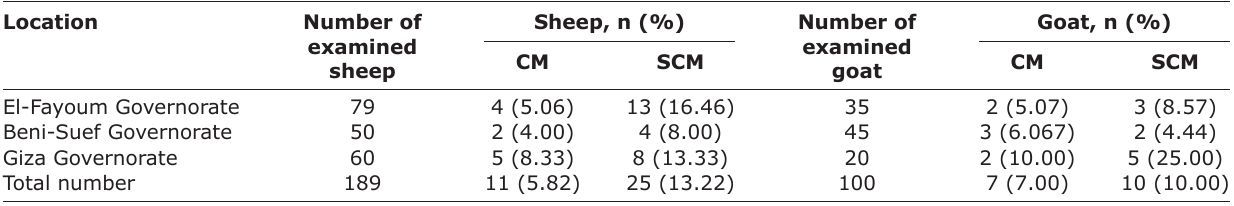
Table-1: Examination of sheep and goat herds for CM and SCM by CMT at different locations.